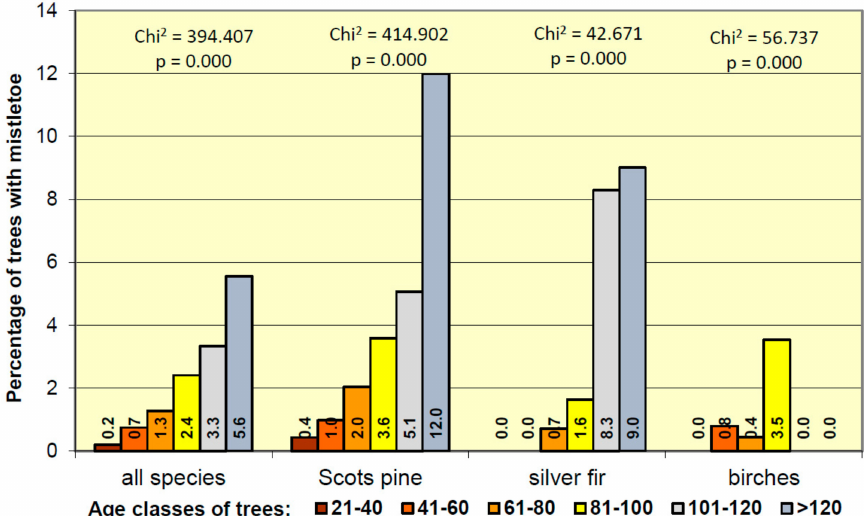
Figure 4. Percentage of trees with injuries caused by mistletoe in relation to 20 years age classes of trees, and the results of the χ 2 test for independence for all trees together (all species), and separately for species most infested by mistletoe (Scots pine, silver fir and